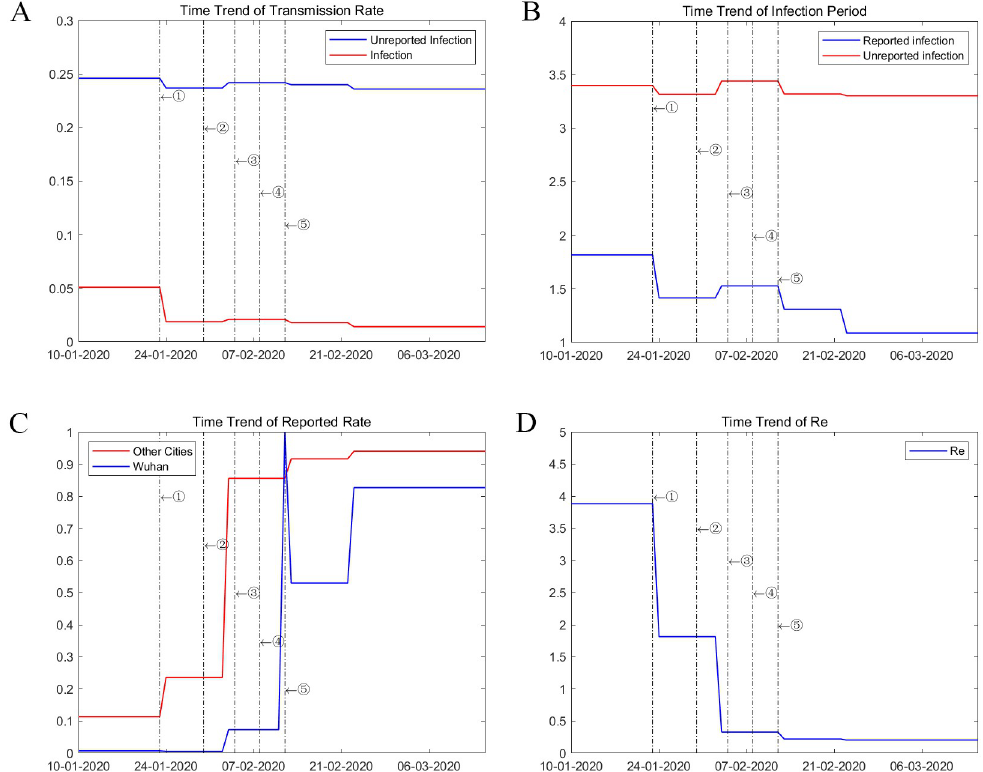
Fig 2. Time trend of parameters. These graph plot the changes in parameter value (A) Transmission Rate, (B)Infectious Period, (C)Detection Rate, and (D)Effective reproduction number estimated over five subperiods: January 10 to